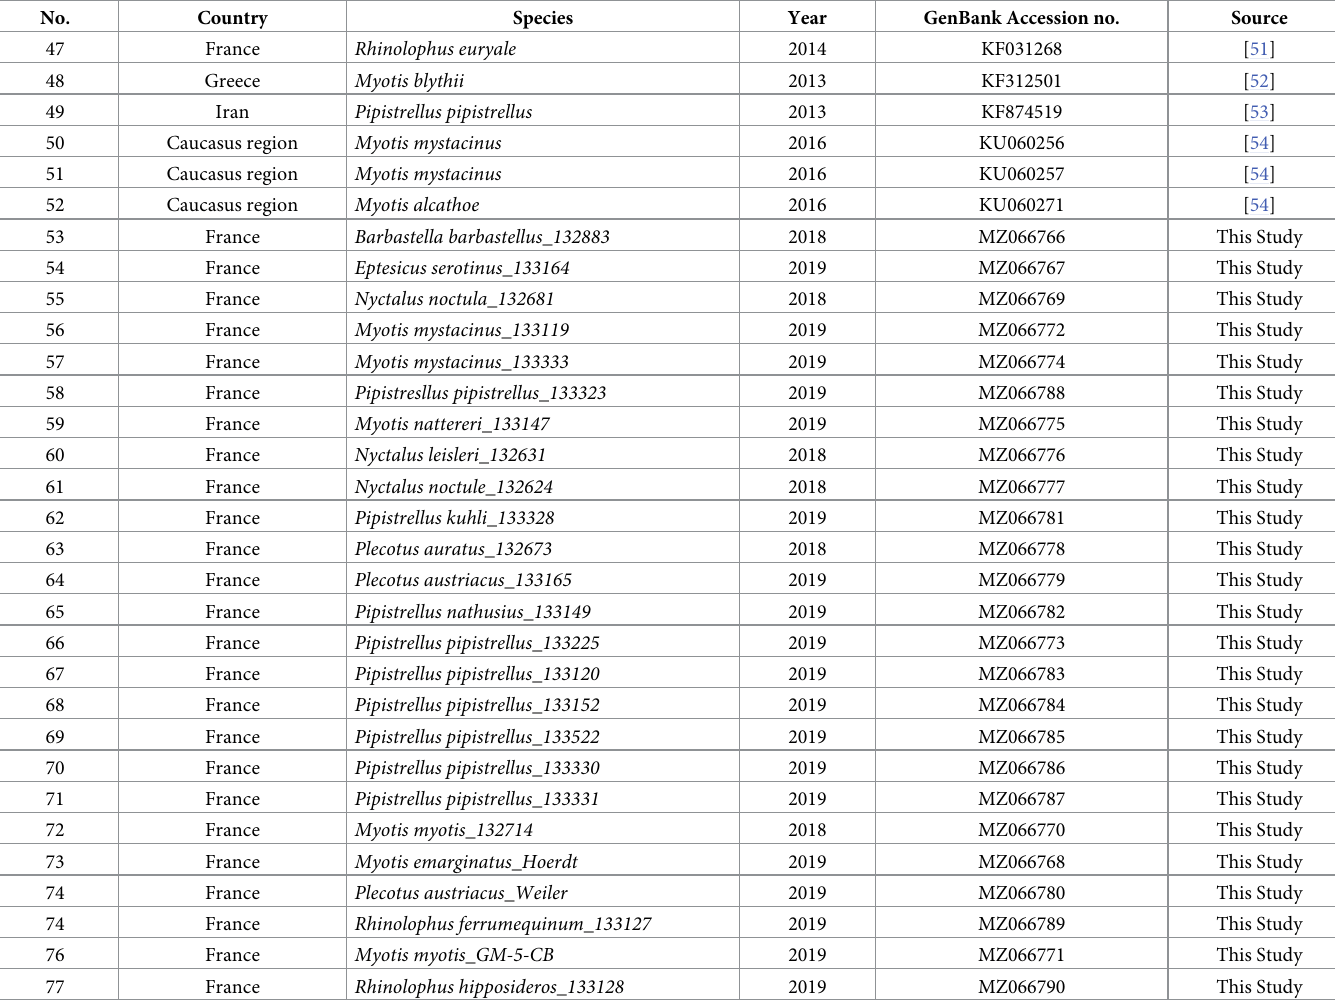
the 3 families currently distributed throughout France with bat species belonging to the fami- lies Miniopteridae (n = 1), Rhinolophidae (n = 2) and Vespertilionidae (n = 19), respectively (Table 5). Twenty species out of the 35 bat species reported to date in France were genetically determined with an over representation of Pipistrelle bats in the sampling (37% = 61/ 163 � 100). BLAST analysis allowed the identification of 2 bat species belonging in the Rhinolo- phidae family with ~96% of nucleotide similarity with the GenBank sequences KU531352 ( R . hipposideros ) and MH029812 ( R . ferrumequinum ) and the identification of M . schreibersii from the Miniopteridae family with 93% of nucleotide similarity with the MK737740 sequence. Within, the Vespertilionidae family, 16 bat species were genetically identified by BLAST with a % nucleotide identity ranging from 87% to 100% (S1 Table). Twenty out of the 156 samples belonging in the Vespertilionidae family could not be identi- fied by BLAST sequence analysis of the cyt b amplicons. These samples had previously been morphologically determined as E . serotinus (n = 6), V . murinus (n = 2), E . nilssonii (n = 1), and Plecotus sp (n = 11). Interestingly, the phylogeny allowed the genetic determination of